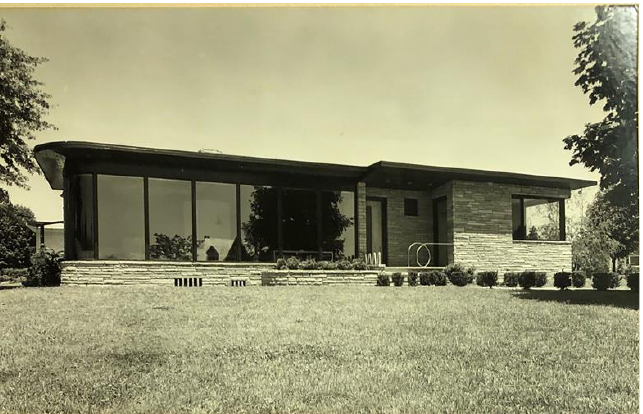
Figure 22. Victor and Anita Bohm: Own residence, Yardley, PA. Source: Linda Bohm’s personal archive.